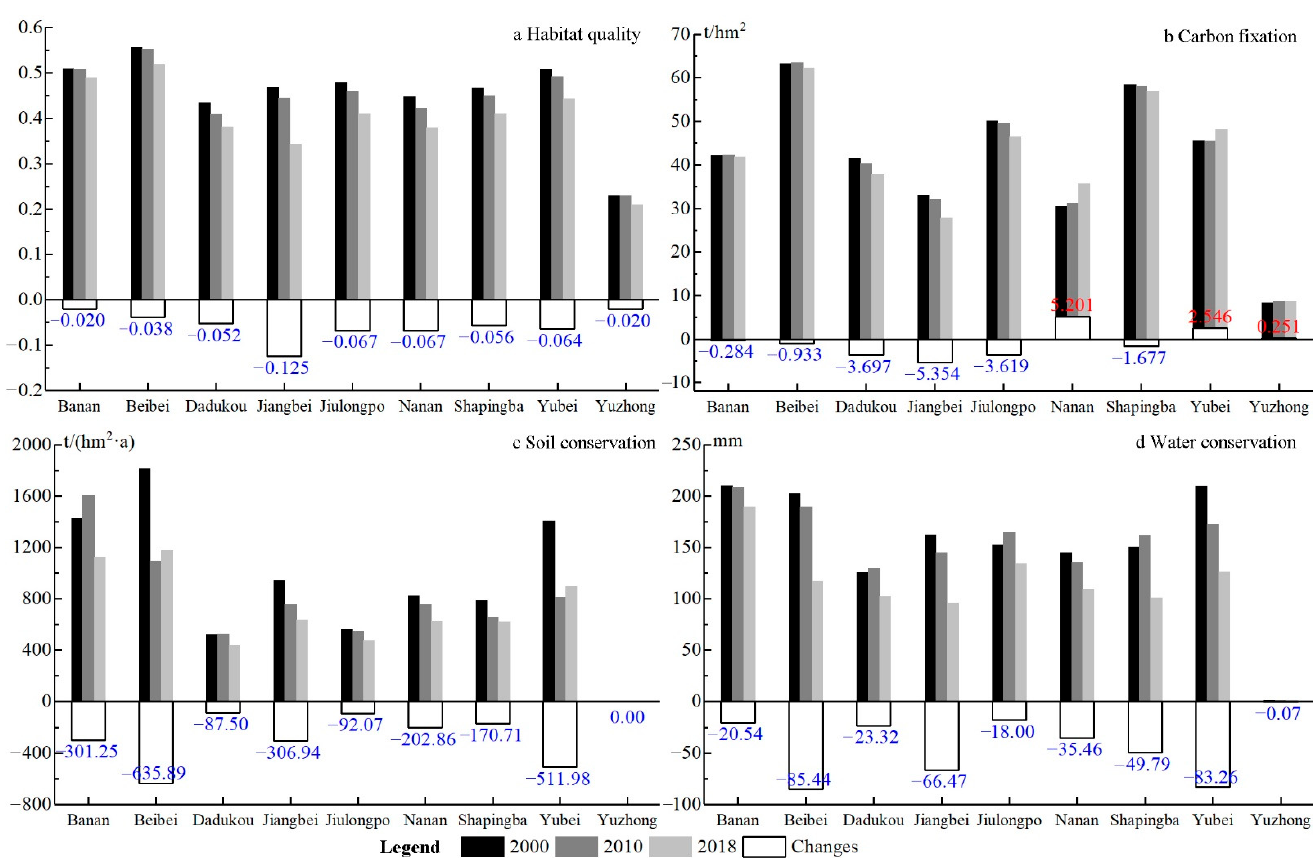
Figure 4. ESs and changes in different administrative districts.